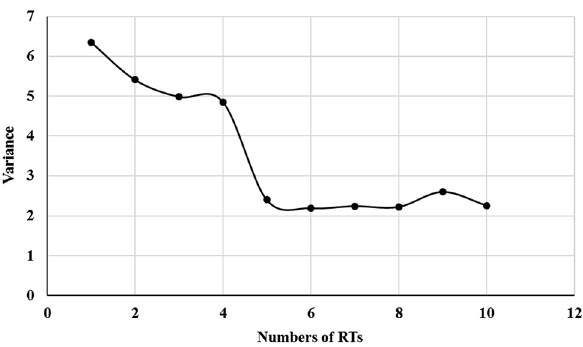
w derived from RTs